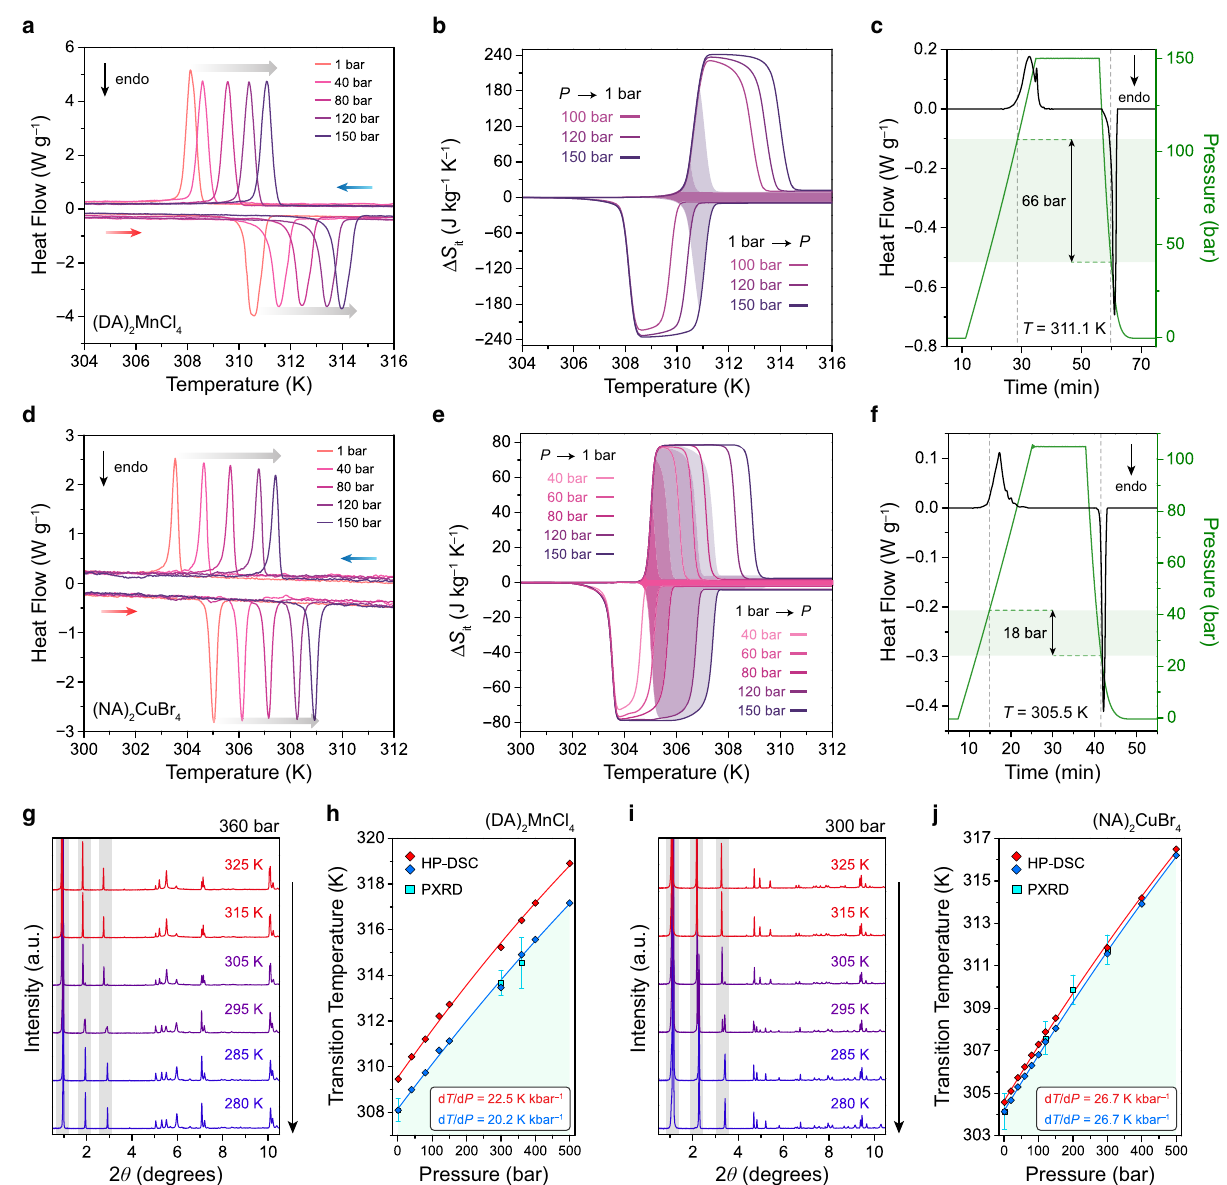
Fig. 3 Barocaloric effects in 2-D metal – halide perovskites. DSC measurements under applied hydrostatic pressure for single-crystal samples of ( a ) (DA) 2 MnCl 4 and ( d ) (NA) 2 CuBr 4 with heating and cooling rates of 2 K min − 1 . Isothermal entropy changes, Δ S it , are calculated by the quasi-direct method for ( b ) (DA) 2 MnCl 4 and ( e ) (NA) 2 CuBr 4 for compression from ambient pressure and for decompression to ambient pressure. The shaded area indicates the reversible Δ S it within this pressure range. Isobaric entropy curves are shown in Supplementary Figs. 10 and 11. Direct evaluation of pressure hysteresis, Δ P hys , through quasi-isothermal DSC experiments for ( c ) (DA) 2 MnCl 4 and ( f ) (NA) 2 CuBr 4 at 311 K and 306 K, with pressure cycling from 1 to 150 bar and to 105 bar, respectively. Δ P hys is calculated as the difference between the onset pressure for the compression-induced exotherm and the decompression-induced endotherm and is indicated by the horizontal green bar. Variable-temperature powder X-ray diffraction (PXRD) patterns for ( g ) (DA) 2 MnCl 4 and ( i ) (NA) 2 CuBr 4 at 360 bar and 300 bar of He, respectively, while cooling from 325 K to 280 K, with an X-ray wavelength of 0.45237 Å. The pressure dependence of the order – disorder transition temperature as determined by HP-DSC (diamonds) and PXRD (squares) is used to calculate the barocaloric coef fi cient, d T /d P , for ( h ) (DA) 2 MnCl 4 and ( j ) (NA) 2 CuBr 4 . Red and blue symbols indicate the phase transition temperatures during heating and cooling, respectively. Barocaloric coef fi cients are summarized in Supplementary Table